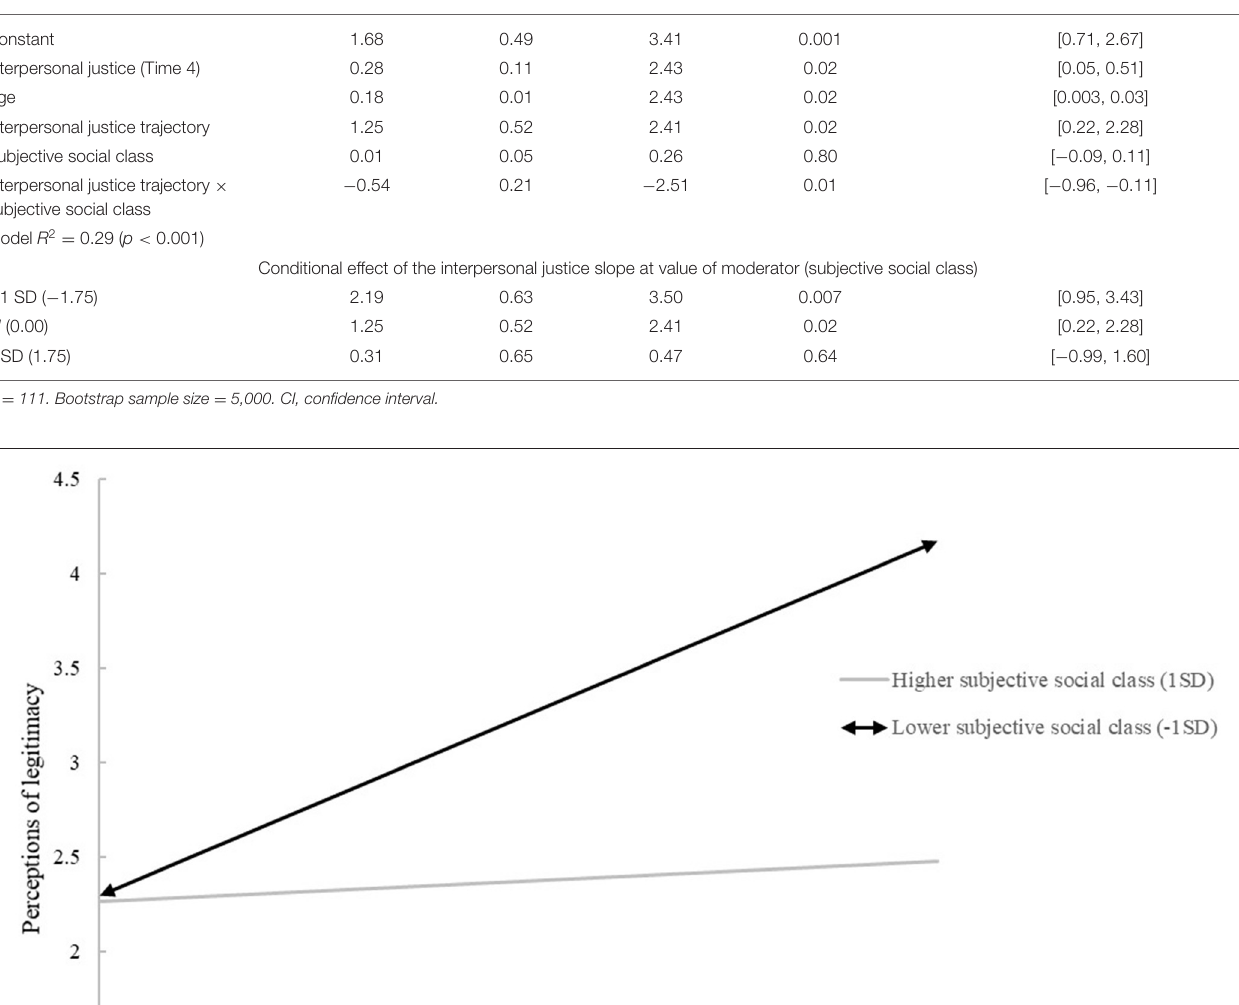
TABLE 4 | Results of interpersonal justice trajectory, subjective social class, and interactions predicting perceptions of legitimacy. Predictor b SE t p 95% CI Constant 1.68 0.49 3.41 0.001 [0.71, 2.67] Interpersonal justice (Time 4) 0.28 0.11 2.43